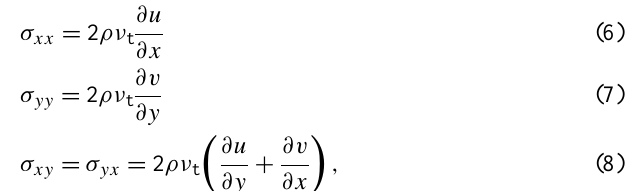
Figure 1. Study location and the elevation of focused